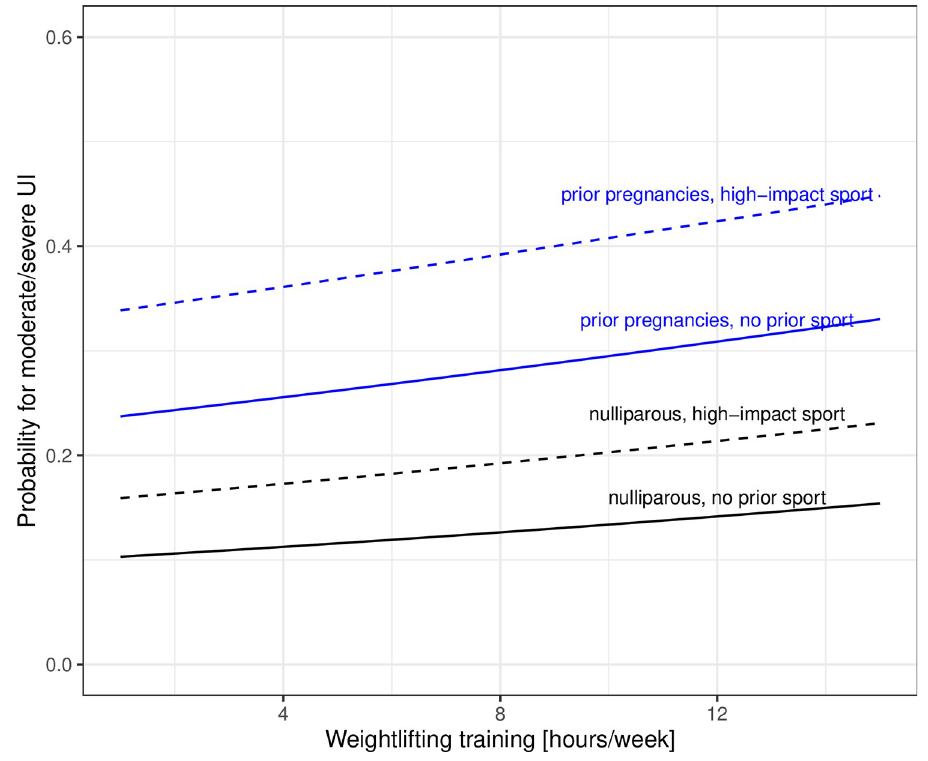
Fig 2. Predicted probability of UI with training